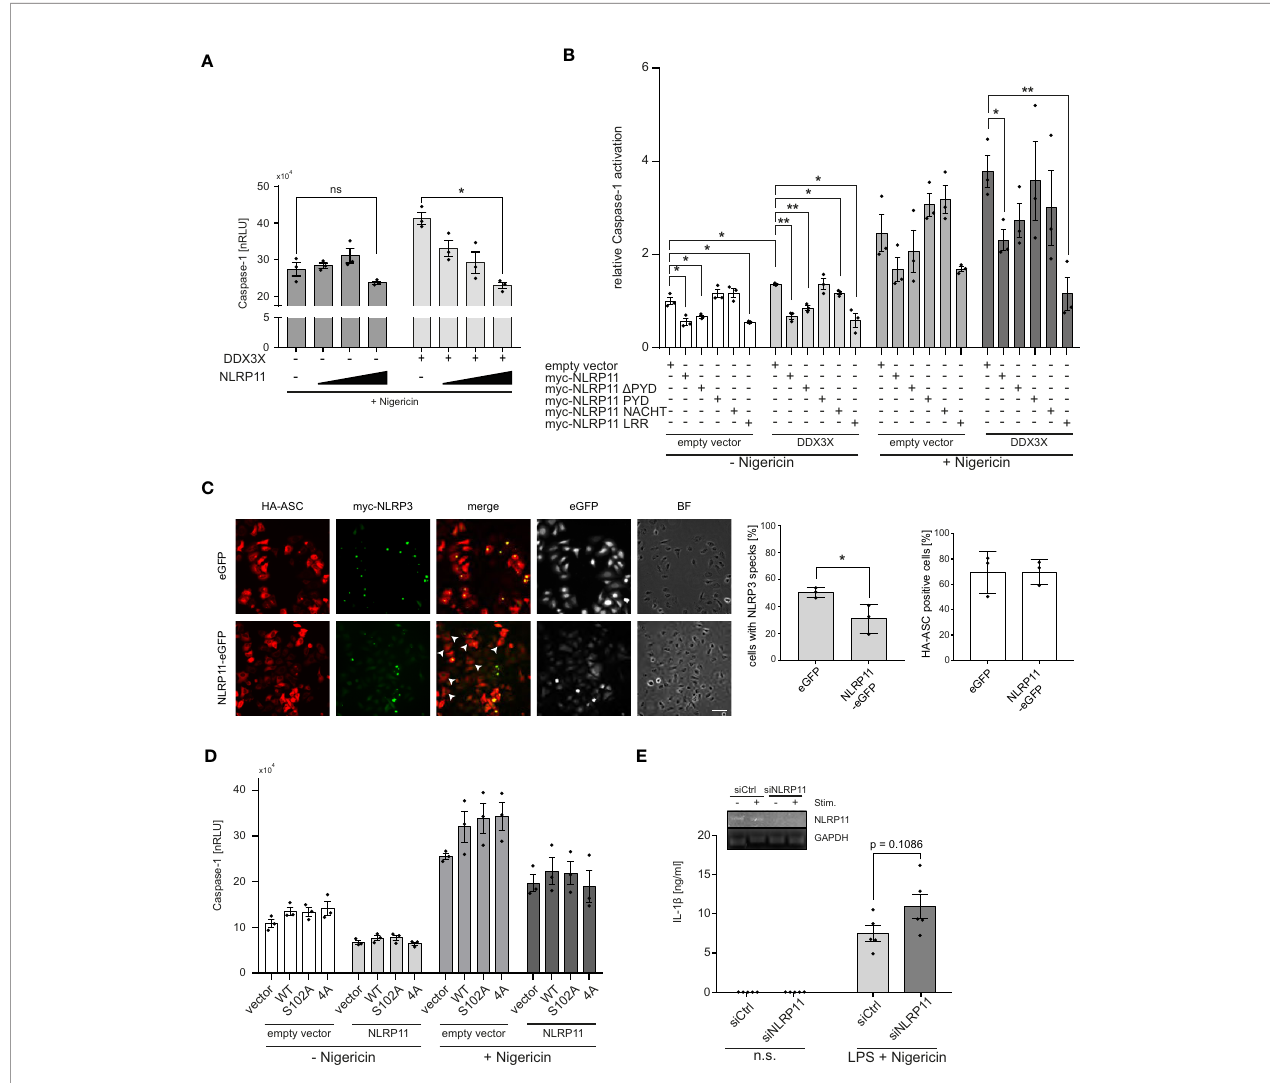
FIGURE 4 | NLRP11 suppresses NLRP3 in fl ammasome activation by DDX3X. (A, B) iGLuc caspase-1 reporter assay in HEK293T cells expressing myc-NLRP3 (15 ng), HA-ASC, and caspase-1 (10 ng each) together with the indicated proteins. Cells were treated with 15 µM nigericin for 3 h. Means of three independent experiments (each conducted in triplicates) ± SEM are shown. *p < 0.05; **p < 0.01 Welch ’ s, two-sided t-test. (B) , values relative to the mean of three independent experiments conducted in triplicates of cells, transfected with the reporter plasmid, NLRP3, ASC and caspase-1, not treated with nigericin, are shown. (C) Indirect immuno fl uorescent micrographs of HeLa-eGFP or HeLa-NLRP11-eGFP cells, induced with doxycycline overnight and transfected with HA-ASC and myc-NLRP3. Staining for HA and myc, as well as eGFP-signal is shown. Images representative of three independent experiments are shown. Scale bar = 50 µm. HA-ASC expressing cells without speck-formation are indicated with white arrow heads. Right panels: Quanti fi cation of cells with myc-NLRP3 specks and quanti fi cation of cells with HA-ASC staining (blinded counting of 150 cells per condition from n = 3). (D) iGLuc caspase-1 reporter assay in HEK293T cells expressing myc-NLRP3 (15 ng), HA-ASC, and caspase-1 (10 ng each) together with the indicated proteins. Cells were treated with 15 µM nigericin for 3 h. Means of three independent experiments (each conducted in triplicates) ± SEM are shown. (E) IL-1 b release from macrophage-like differentiated THP1 cells after 72 h of siRNA-mediated knock- down. Cells were primed for 4 h with 100 ng/ml LPS followed by stimulation with 10 µM nigericin for 2 h. Means of fi ve independent experiments ± SEM are shown. Inlay: endpoint PCR for NLRP11 and GAPDH of a representative experiment for validation of knock-down ef fi ciency. n.s., not